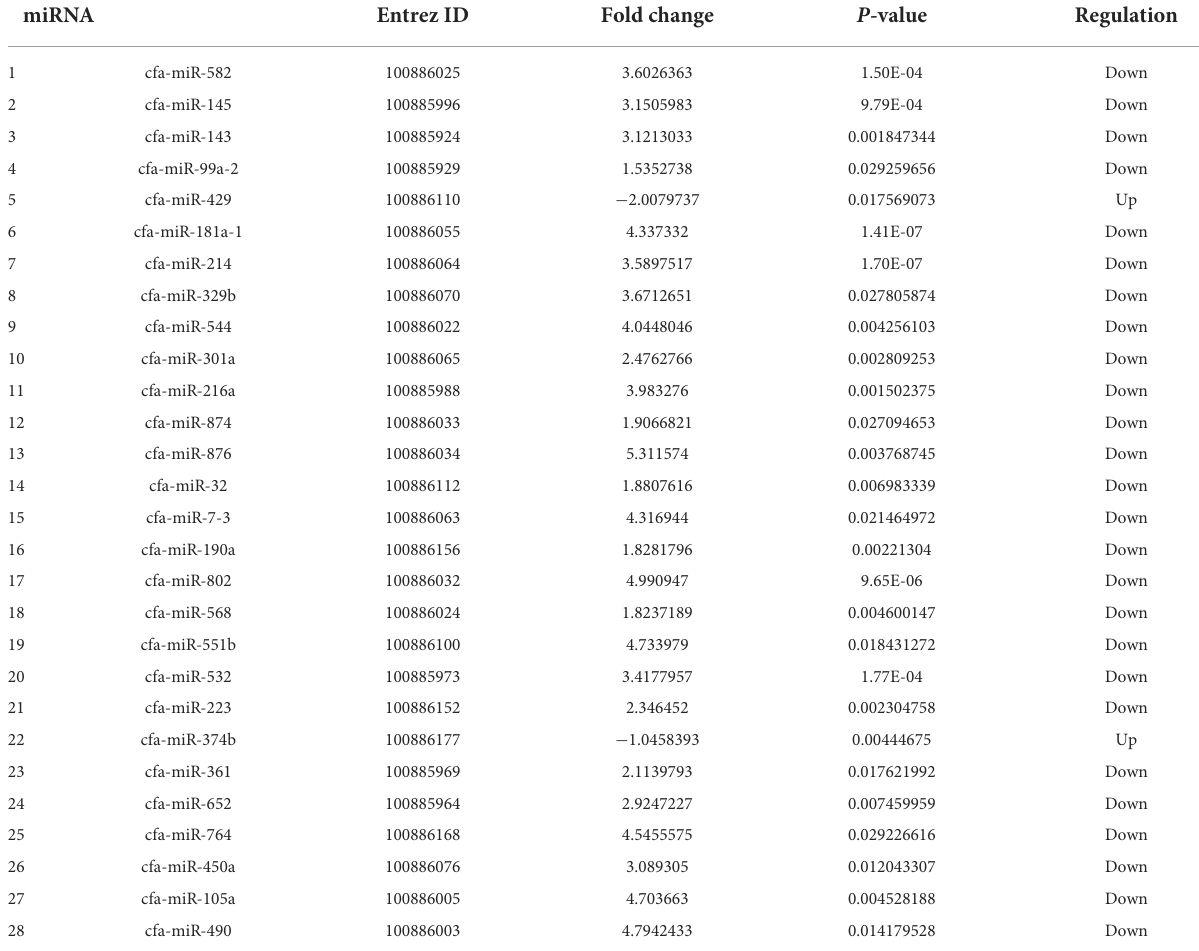
TABLE 1 Differentially expressed miRNAs in invasive urothelial carcinoma compared to healthy bladder urothelial control tissue by RNA-Seq. miRNA Entrez ID Fold change P